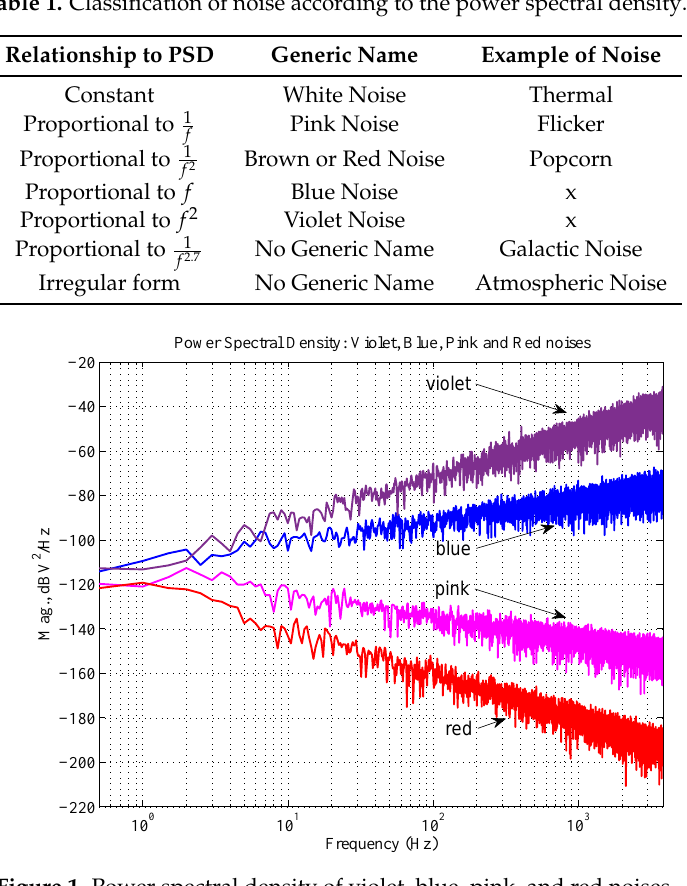
Figure 1. Power spectral density of violet, blue, pink, and red